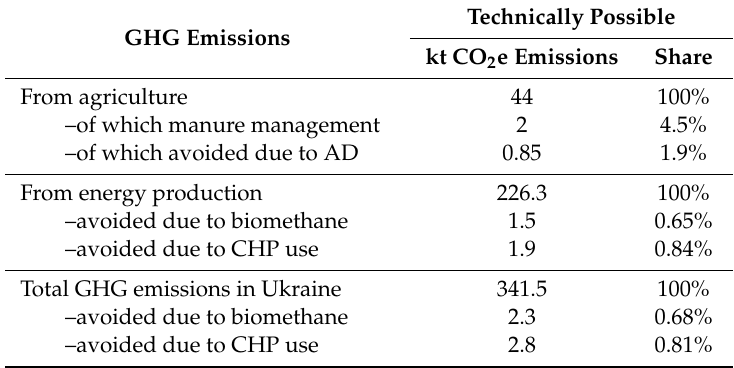
Table 7. Impact of agricultural biogas production on GHG emission on Ukraine.